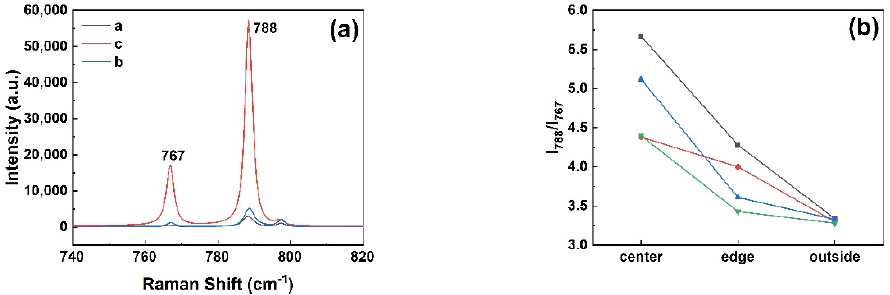
Figure 10. ( a ) Raman spectra of 6H-SiC micropipes; ( b ) intensity ratio of the peak at − 788 cm -1 and the peak at − 767 cm -1 at different positions.